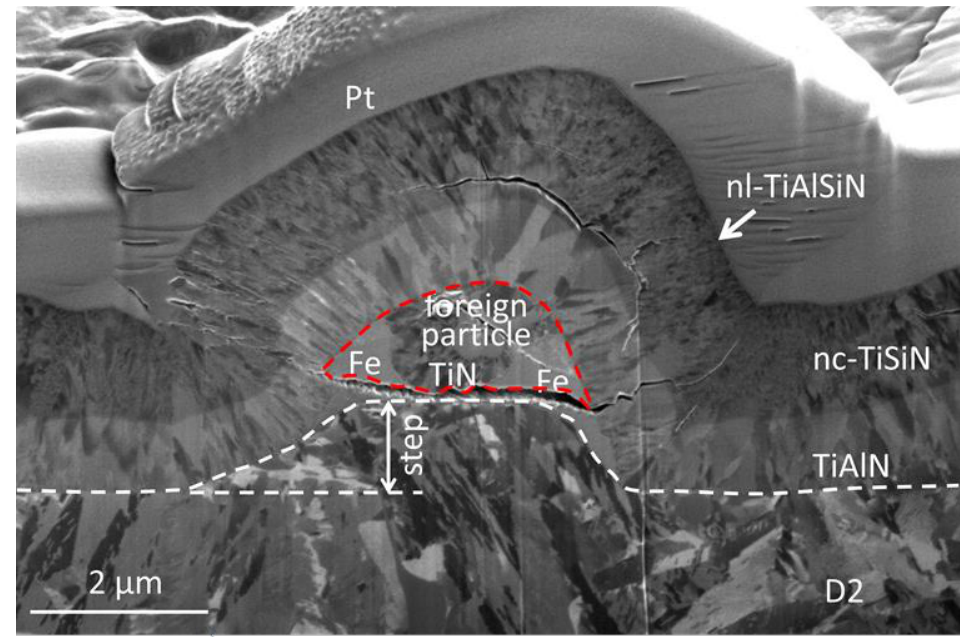
Figure 29. The SEM image was taken at the FIB cross-section of the nodular defect in a nanostructured TiAlN/TiSiN/TiAlSiN hard coating. The nodular defect was formed at the site of a foreign particle. A step on the substrate surface beneath this particle proves that it was on the substrate surface even before etching. The substrate beneath the foreign particle is about 0.8 µm thicker than surrounding area, exposed to ion etching.